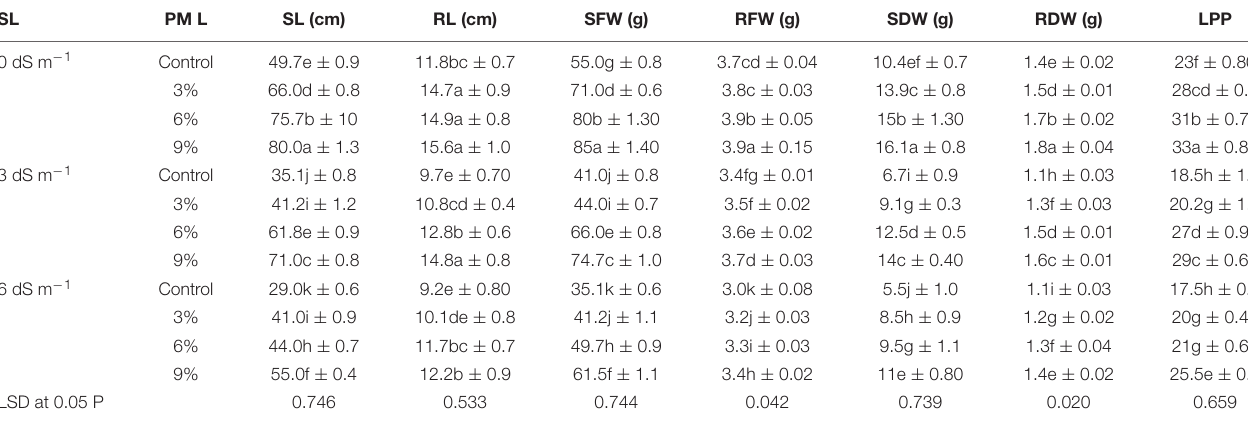
TABLE 1 | Effect of different levels of press mud application on growth attributes of rice plants grown under different levels of salinity stress. SL PM L SL (cm) RL (cm) SFW (g) 0 dS m −